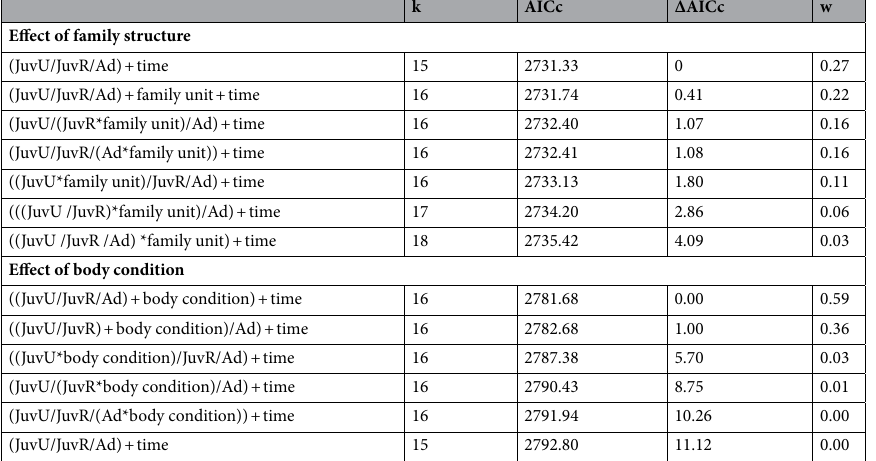
Table 5. Effects of family units and body condition on the juvenile and adult survival probabilities of urban and rural burrowing owls Athene cunicularia ringed as chicks. All models considered the effect of field effort on recapture probabilities (see Table S2). Note that for body condition analyses, all models considered differences between adults, urban juveniles, and rural juveniles and additive temporal variation among groups (see Table S3). k: number of parameters, AICc: Akaike Information Criterion corrected for small sample sizes, ΔAICc: the difference between the AICc of model i and that of the best model (i.e. the model with the